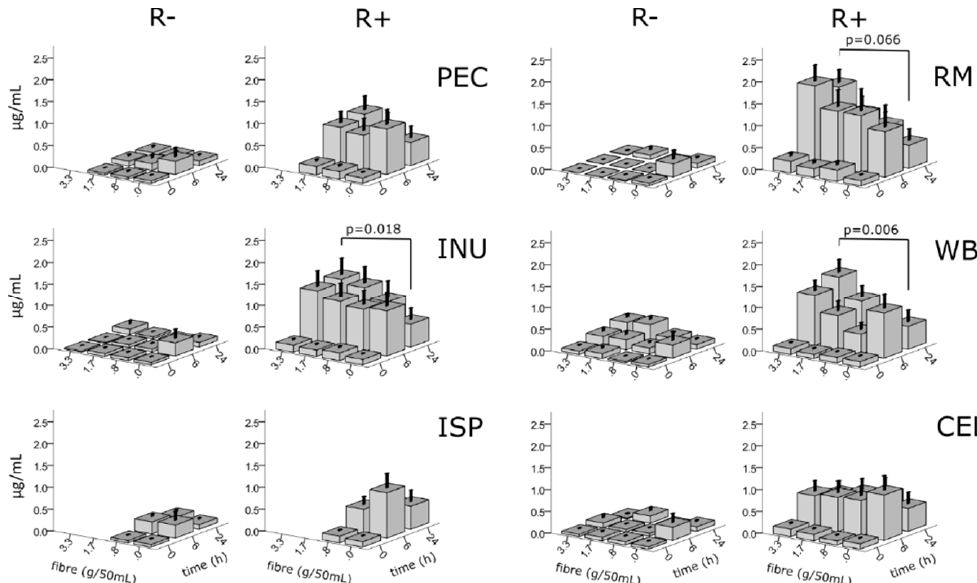
Figure 3. Concentration of 3,4diOHPAA in fermentations in the presence of fibres at four concentrations (0, 0.8, 1.7 and 3.3 g / 50 mL) in fermentations with rutin (R + ; 20 µ g / mL) and without rutin (R-); INU, inulin, PEC, pectin, ISP, ispaghula, RM, pyrodextrin, WB, wheat bran, CEL, cellulose; means ± S.E.M; independent samples t-test (2-tailed), n =